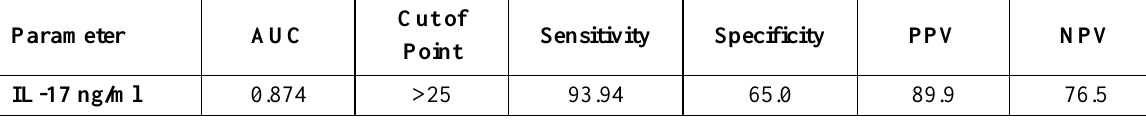
Table 4. Cut-off value of serum IL-17 level as a predictor between patients and control.